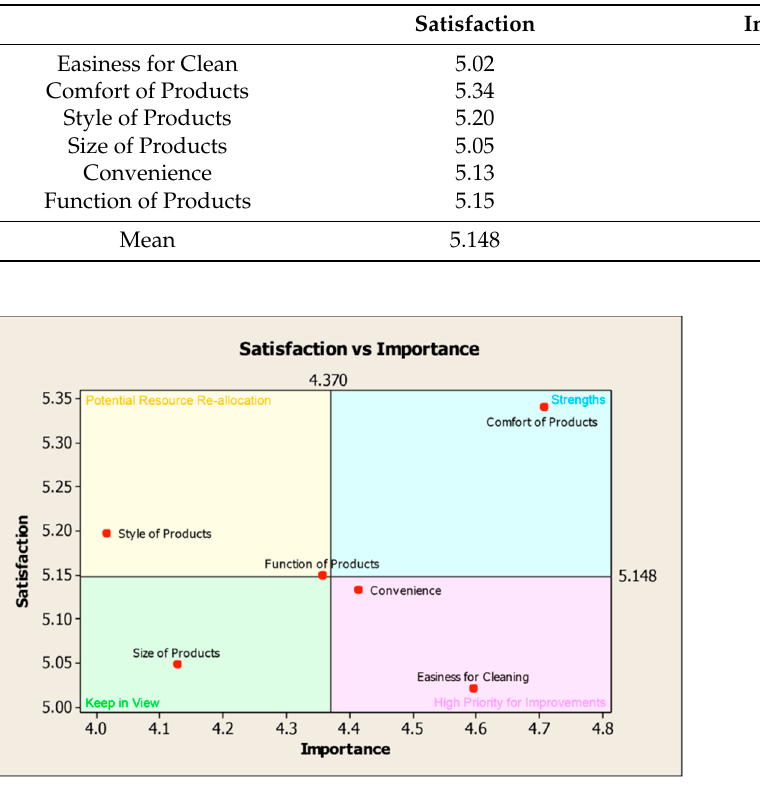
Figure 5. Matrix showing the relative importance and satisfaction level.